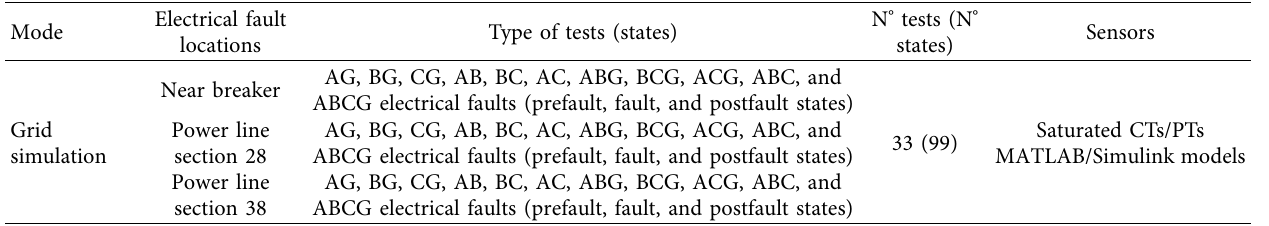
Table 3: Grid simulations tests.